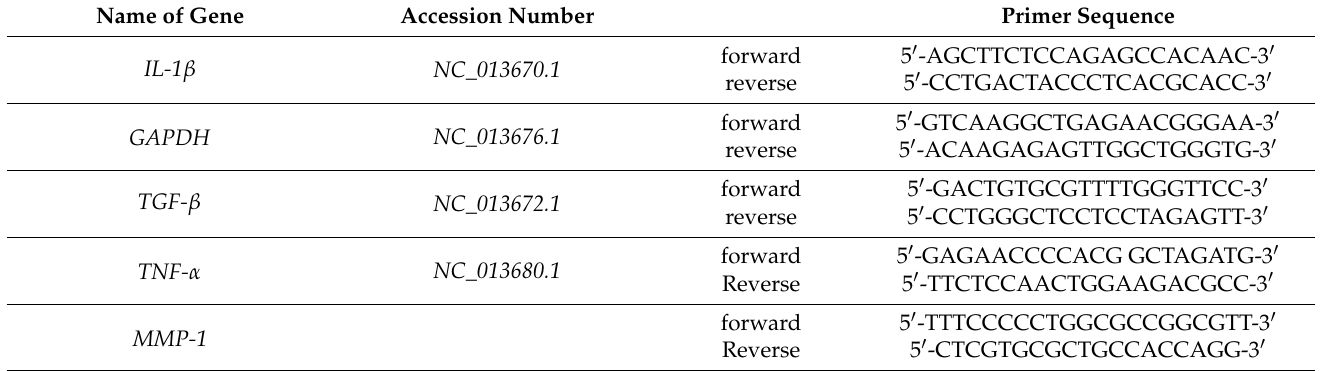
Table 1. Primers used for real-time